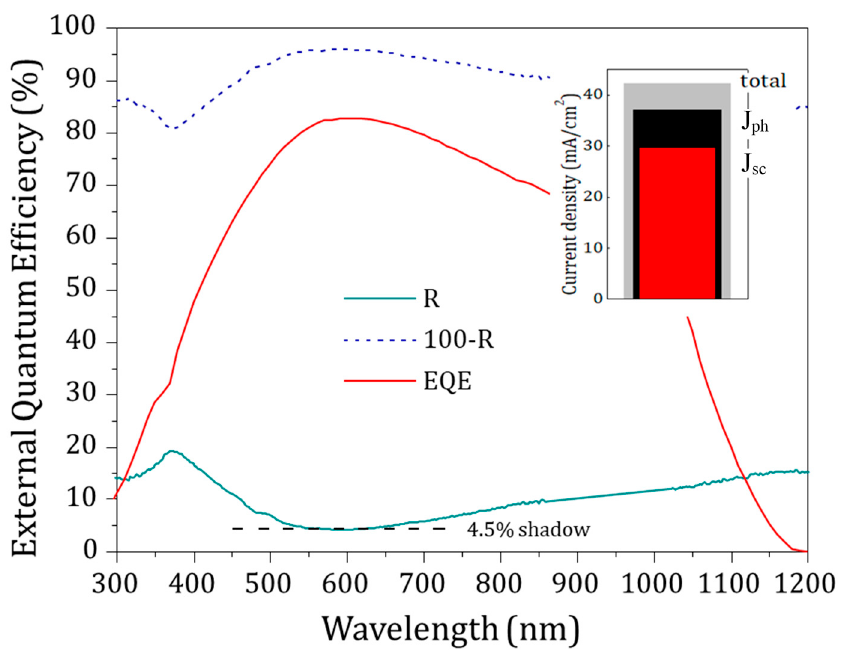
Figure 11. EQE curve of the solar cell together with its front reflectance spectra. Inset shows charge-carrier generation and different loss mechanisms balanced for an AM 1.5 irradiance.